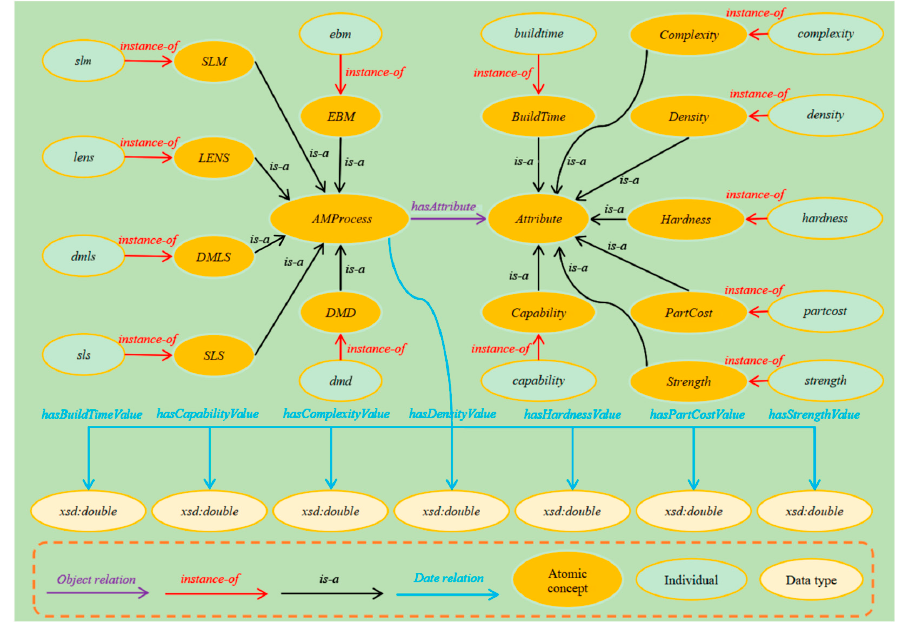
Figure 2. Ontological view of automatic generation of AM machine attribute values.